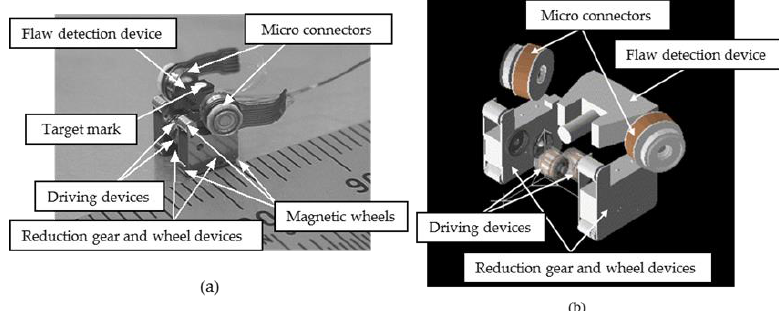
Figure 15. ( a ) Photograph of the microrobot prototype, ( b ) exploded view of the microrobot prototype. Configuration of a prototype of magnetic wheeled microrobot. It consisted of four